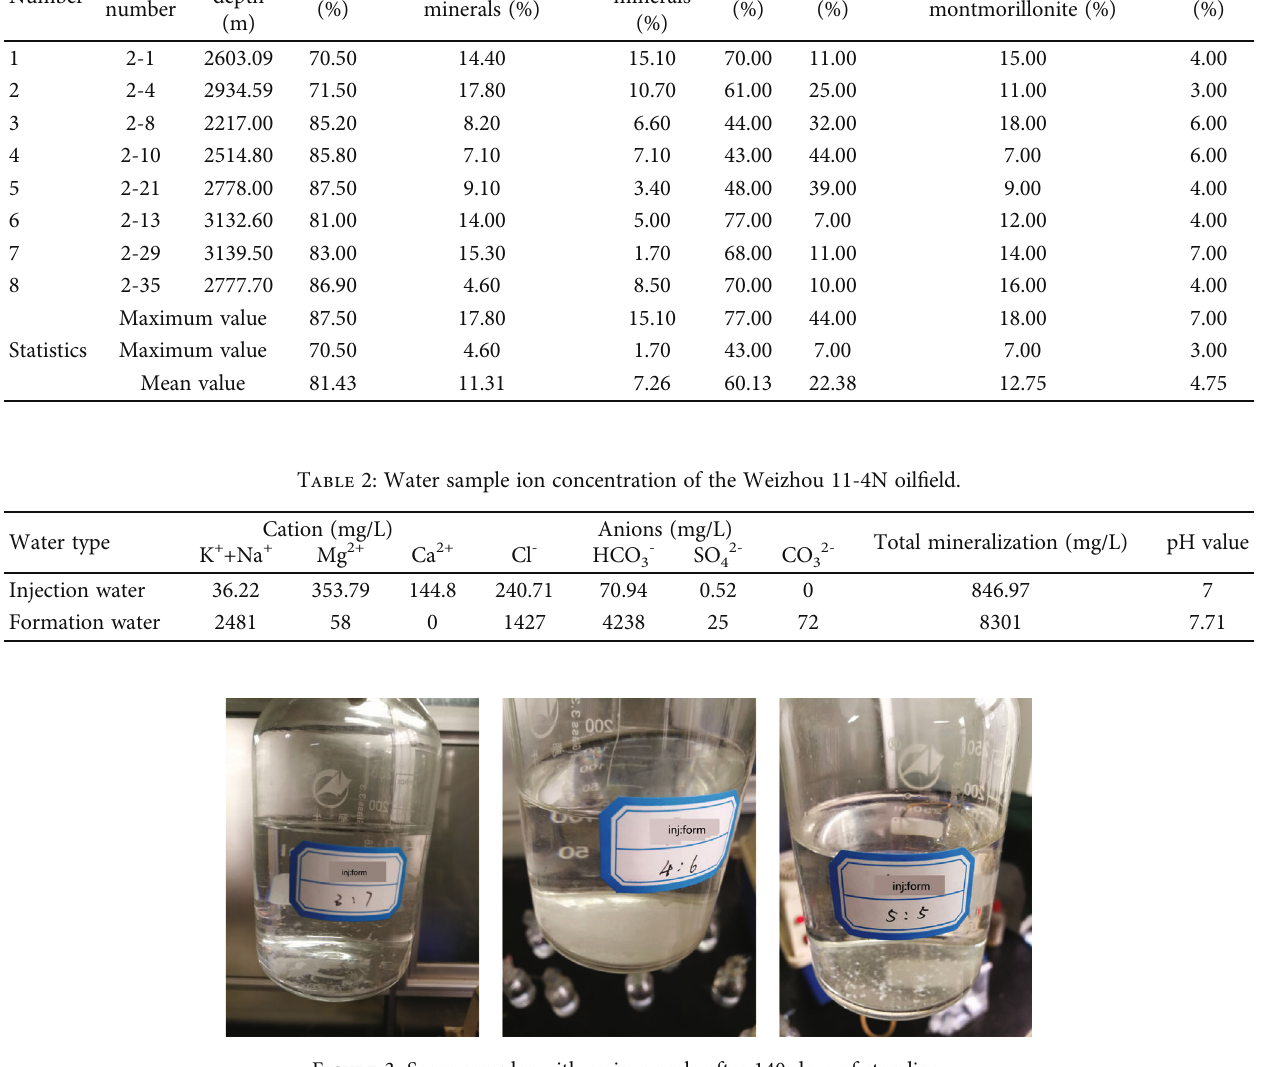
Table 1: clay mineral composition table of L